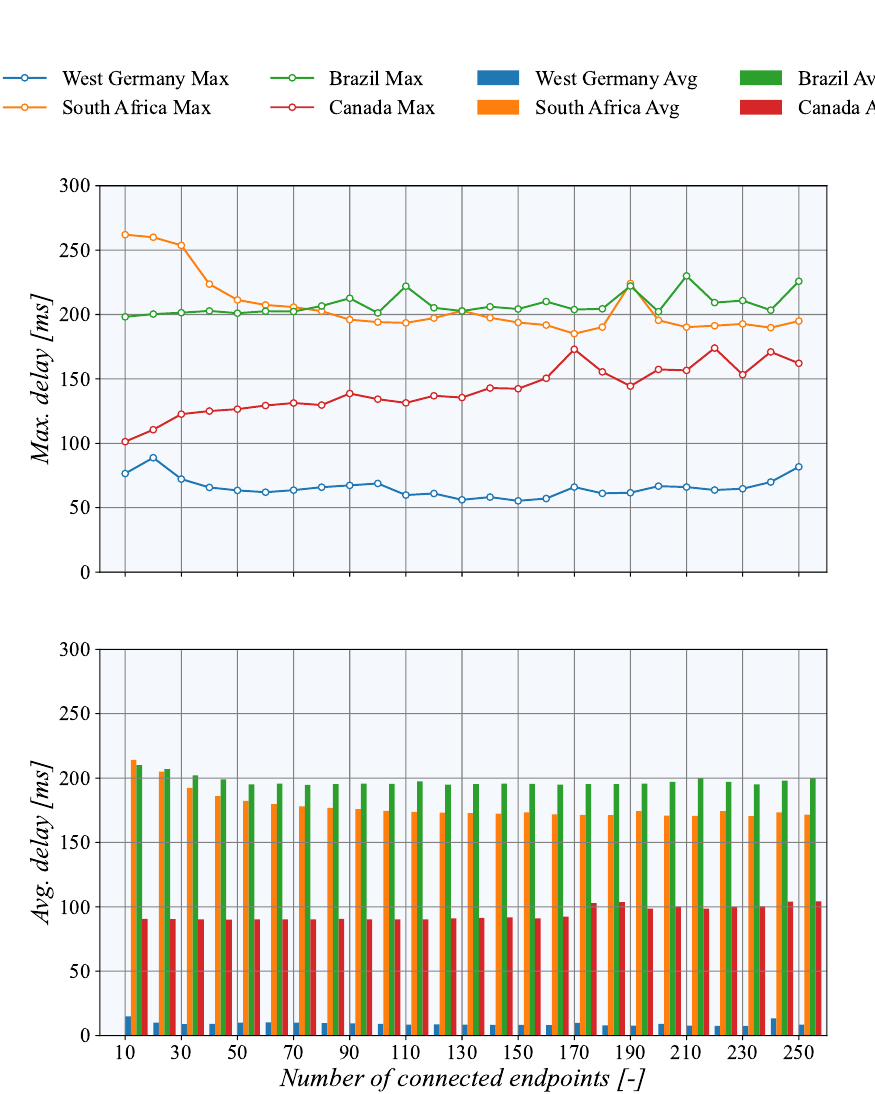
Figure 11. Communication delays of PUSH test measurements for different Azure